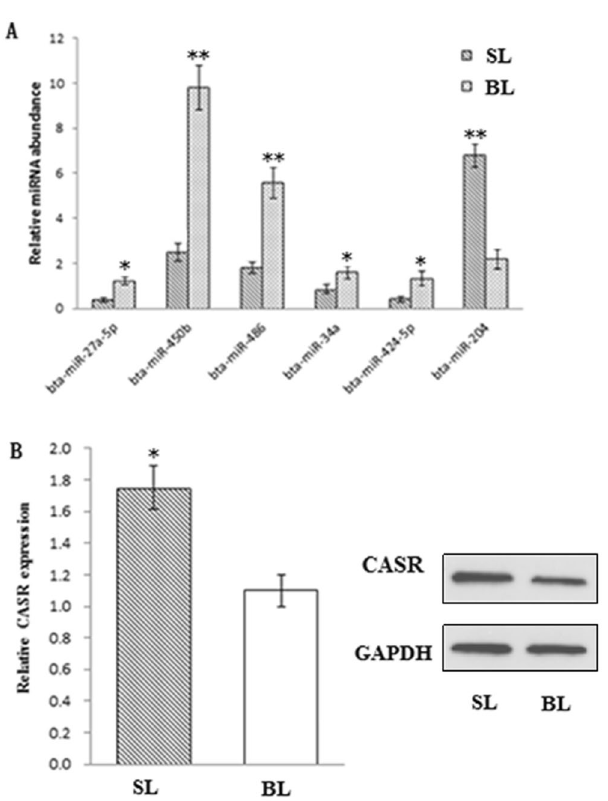
Figure 4. ( A ) The expression of miRNAs in BL and SL. ( B ) The mRNA and protein expression of CASR gene in BL and SL. Values are presented as the means ± S.E.M. “ * ”Represents significant differences P < 0.05; “ ** ”represents significant differences P <